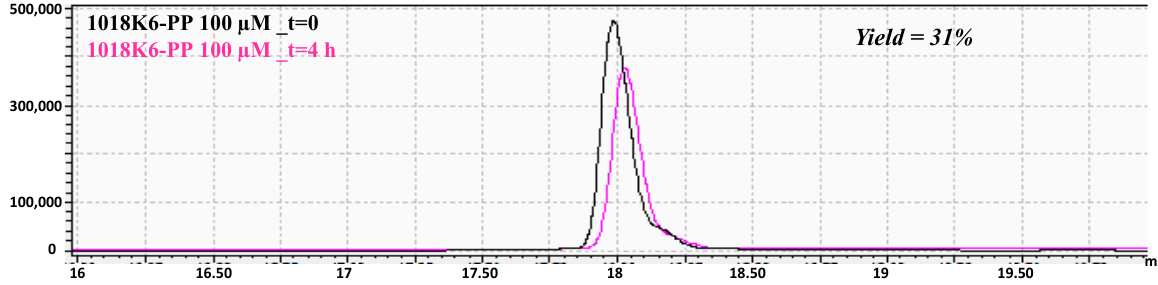
Figure 1. Immobilization yield (%) of 1018K6 on PP surfaces determined by RP-HPLC chromatography on a C18 column after the coupling reaction. PP surfaces pre-activated by plasma treatment, were incubated with a water solution of 1018K6 (100 μ M). After the coupling reactions, the supernatants were recovered and analysed by RP-HPLC. The peptide solution (100 μ M) at time 0 (t = 0) was used as control. The reported chromatograms are representative of three independent experiments.